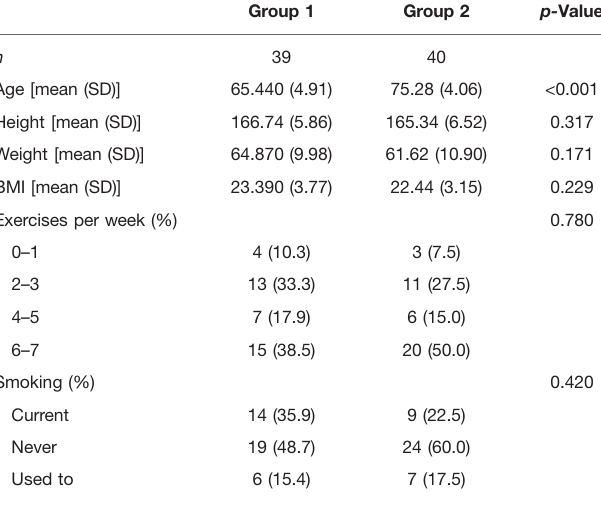
TABLE 1 | Baseline characteristics of patients enrolled.